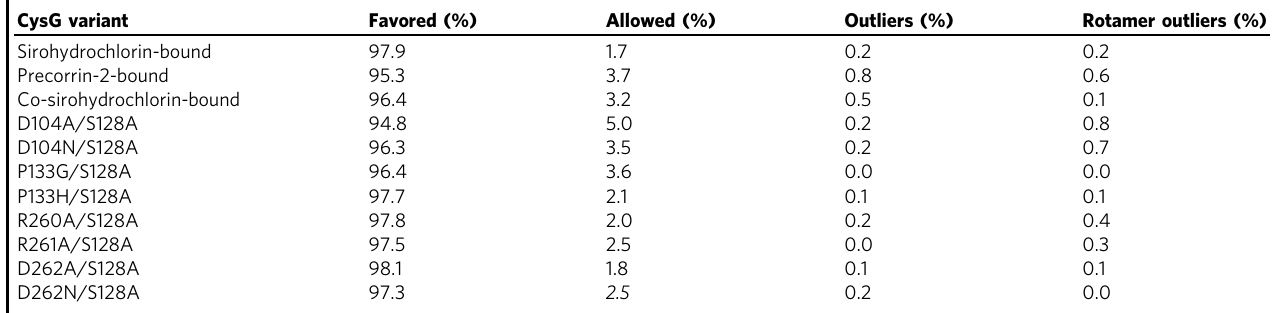
Table 2 Ramachandran statistics for tetrapyrrole-bound and amino-acid variant CysG structures. CysG